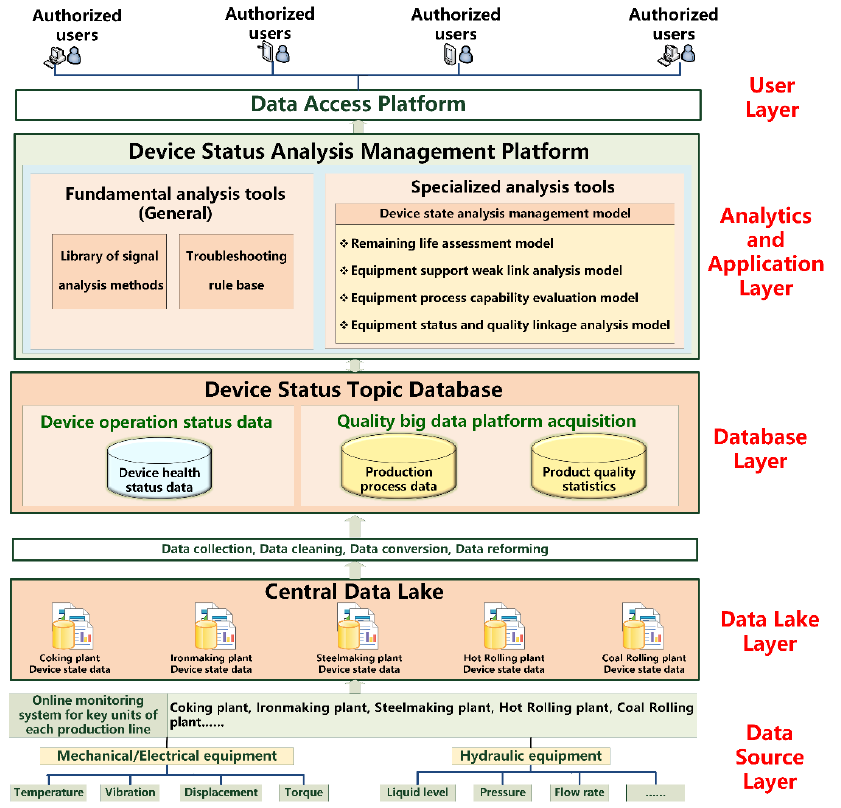
Figure 5. Architectural design for equipment troubleshooting systems in China’s steel industry.